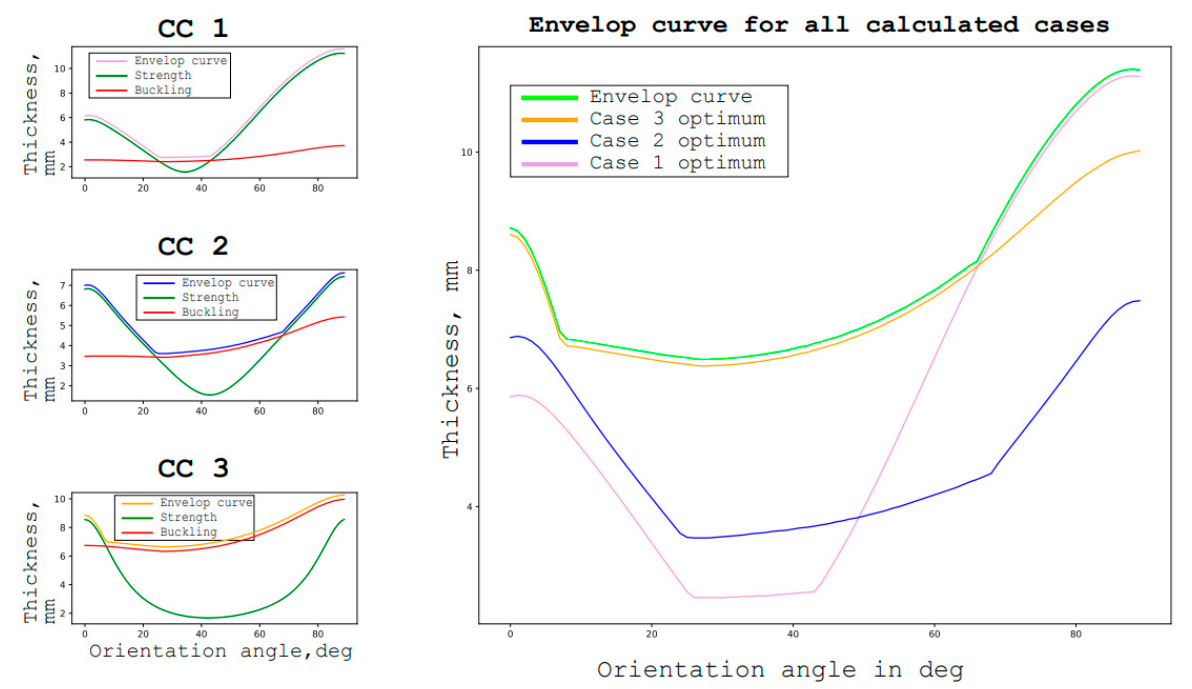
Figure 7. Strength and buckling failure coefficient for different layer orientations for various observed cases for a specific case